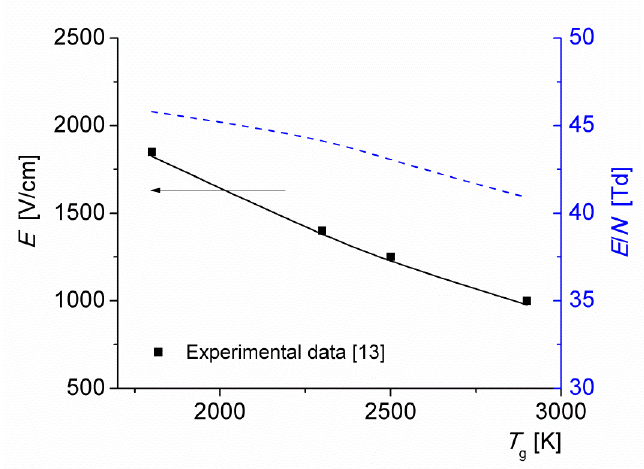
Figure 7. Electric field strength (solid line) and reduced electric field (dashed line) as functions of the initial gas temperature of the discharge T 0 for j = 1 A/cm 2 .